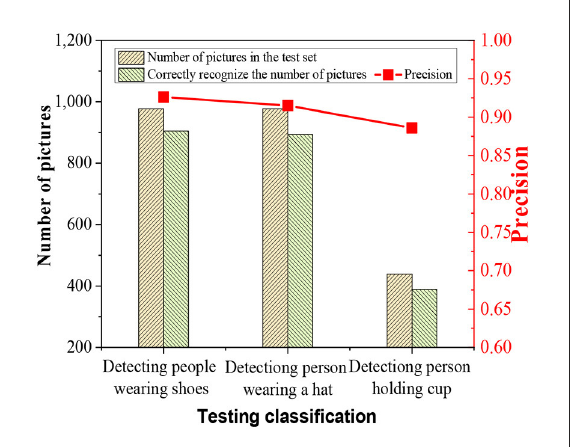
FIGURE7 Behavior recognition result graph of the test set